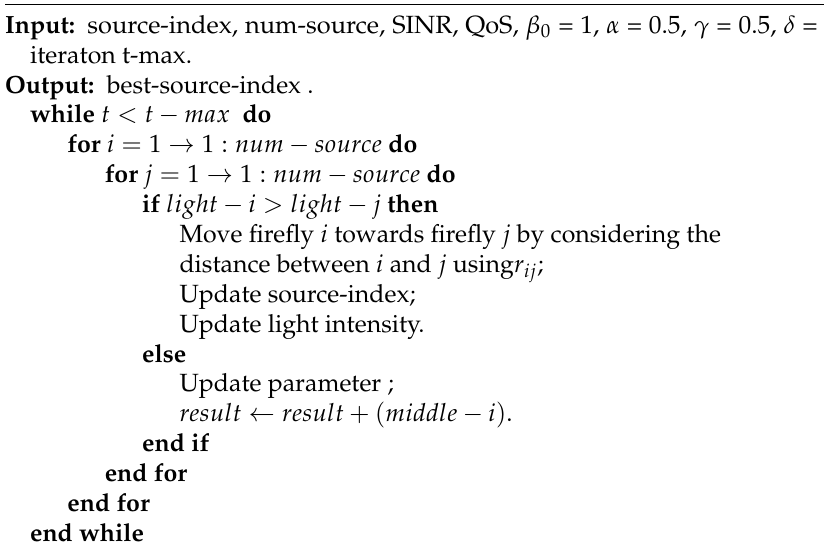
Algorithm 1 Improved discrete firefly